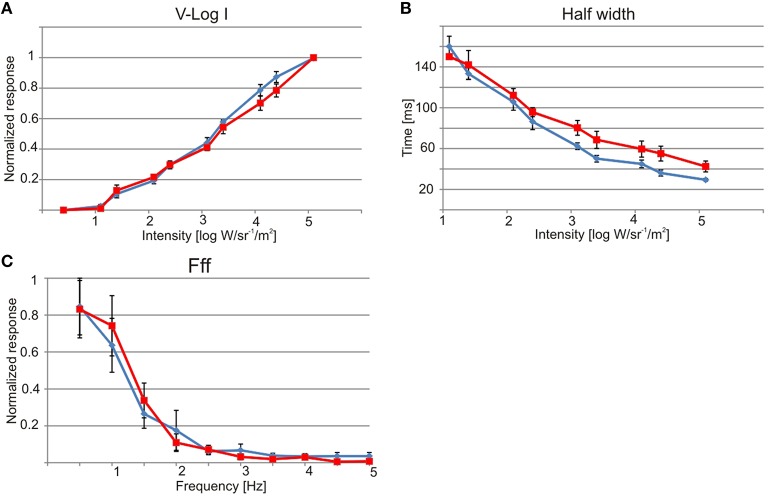
Physiology of the lens eyes. Upper lens eye (ULE) in blue and lower lens eye (LLE) in red. (A) V-log I curve showing a dynamic range of about four log units from ~10 to 1 × 105 W/sr/m2. (B) The half width of the impulse response decrease with increasing intensity. At max intensity the half width was 29 ms for ULE and 42 ms for LLE. (C) Both lens eyes are very slow and had flicker fusion frequencies (fff) of about 2.5 Hz. All curves are showing mean ± S.E.M. N = 7, except for (C) where N = 5.